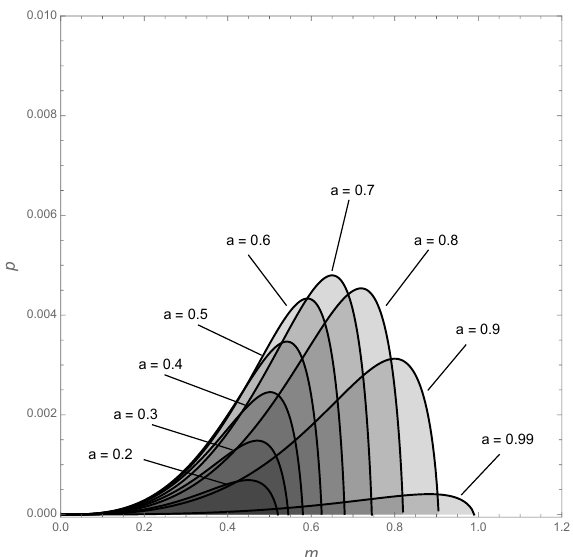
Figure 2 . The shaded areas indicate regions in the parameter space where the NEC (as well as the SEC) is violated, for various values of the dilaton coupling 0 < a < 1. Note the smallness of vertical